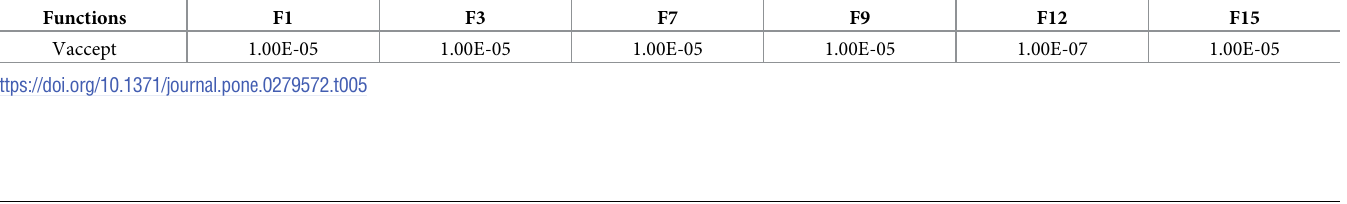
Table 5. Test functions and convergence thresholds.